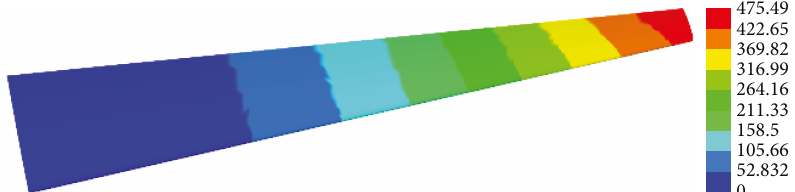
Figure 17: Deformation cloud diagram with the layer sequence being [0/45/90/-45/0]